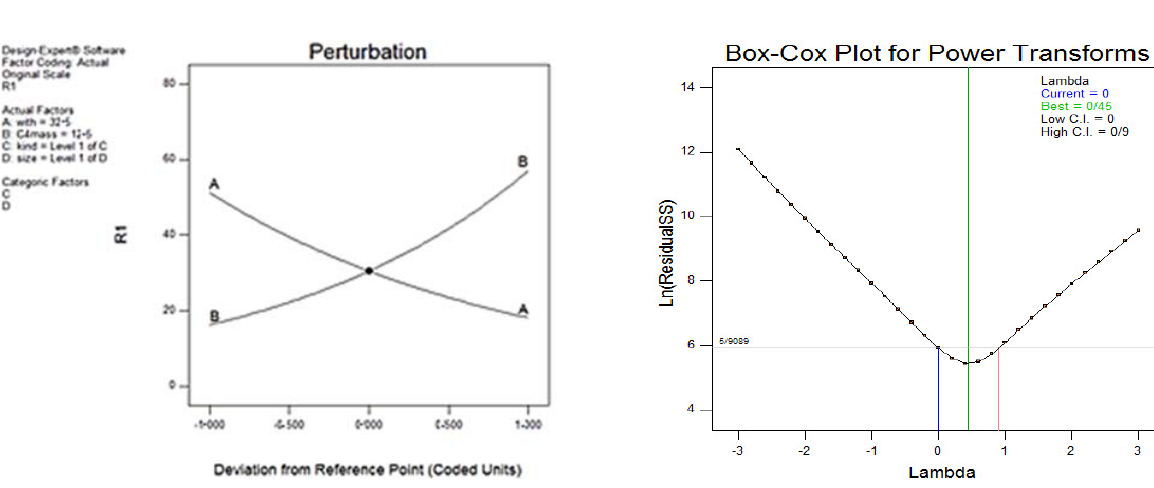
Figure 26: Perturbation diagram for pea specimen. Figure 27: Cox Box Curve.